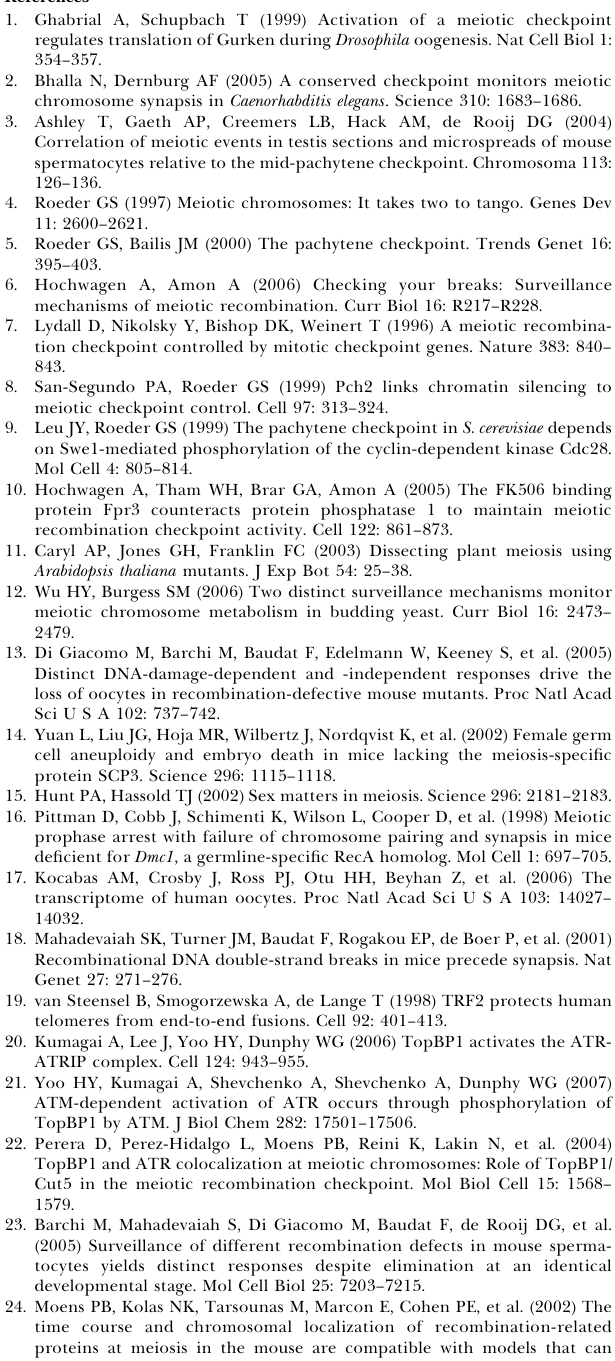
Figure S3. Trip13 Mutant Spermatocytes That Progress Beyond Pachynema Have Repaired DSBs and Form Bivalents at Metaphase I Found at doi:10.1371/journal.pgen.0030130.sg003 (1.5 MB PDF). Table S1. Sources of TRIP13 Amino Acid Sequences Used to Construct the Phylogenetic Tree in Figure 1 Found at doi:10.1371/journal.pgen.0030130.st001 (22 KB